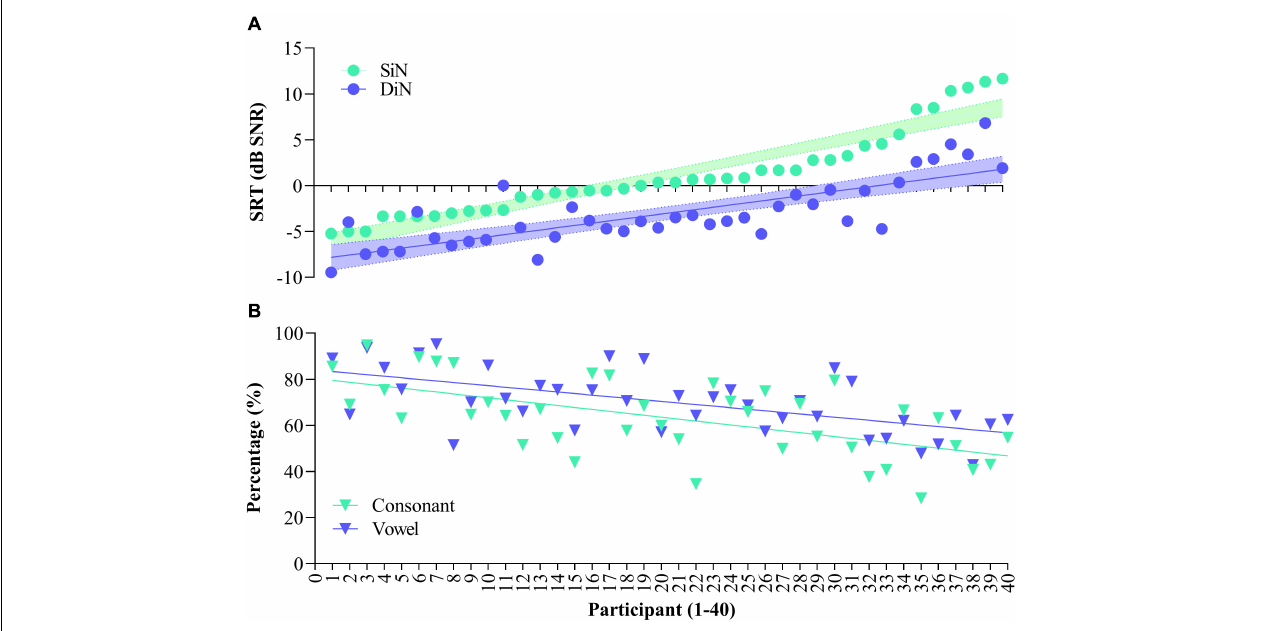
FIGURE 1 | Speech reception thresholds for Sentence in noise (SiN) and Digits in noise (DiN) for the 40 participants (A) and concomitant vowel and consonant scores [percentage correct, (B) ]. Data are ranked according to SiN. DiN and phoneme recognition data are based on the average of the last 5